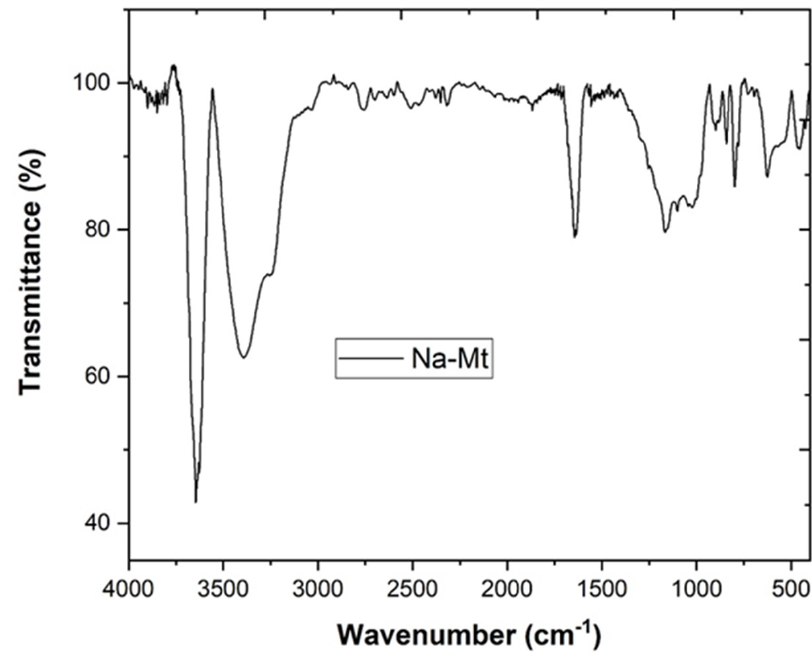
Figure 1. Fourier-transform infrared spectroscopy (FTIR) spectra of Na-Mt.